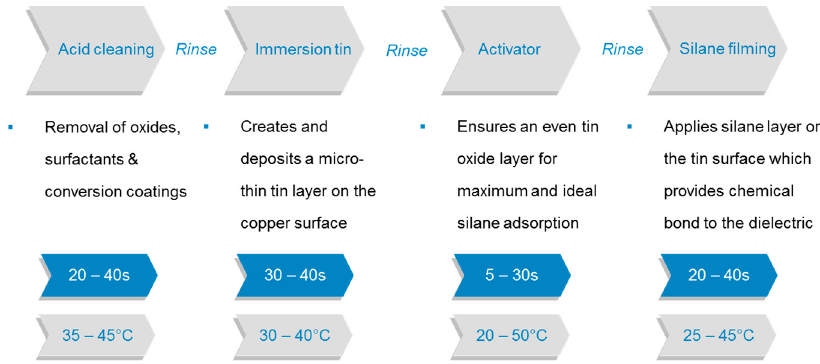
Figure 7. Schematic representation of the white oxide process.